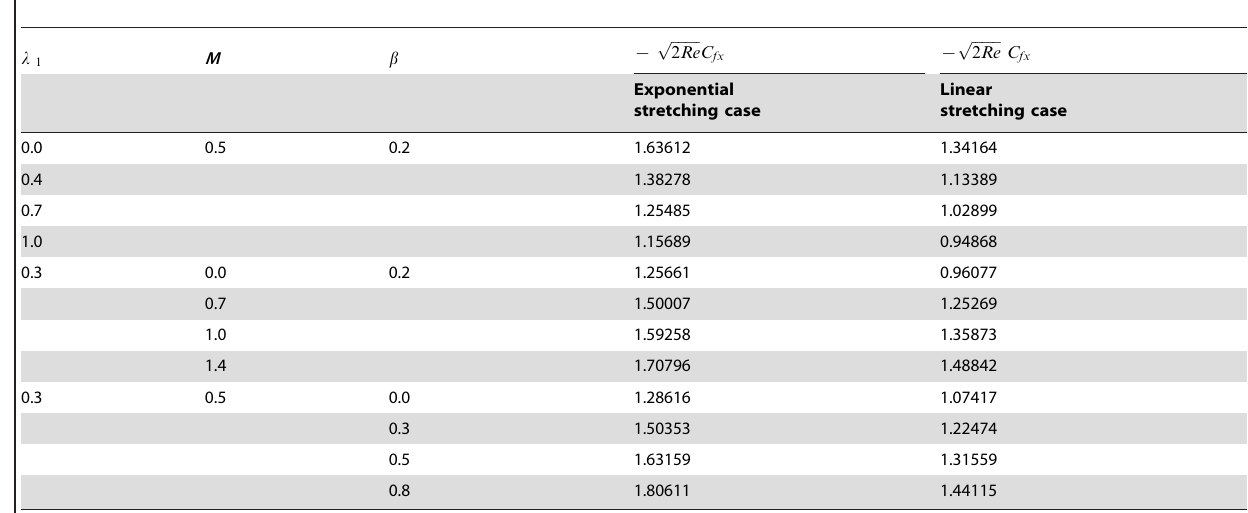
Table 2. Numerical values of skin friction coefficient ffiffiffiffiffiffiffiffi 2 Re stretching.